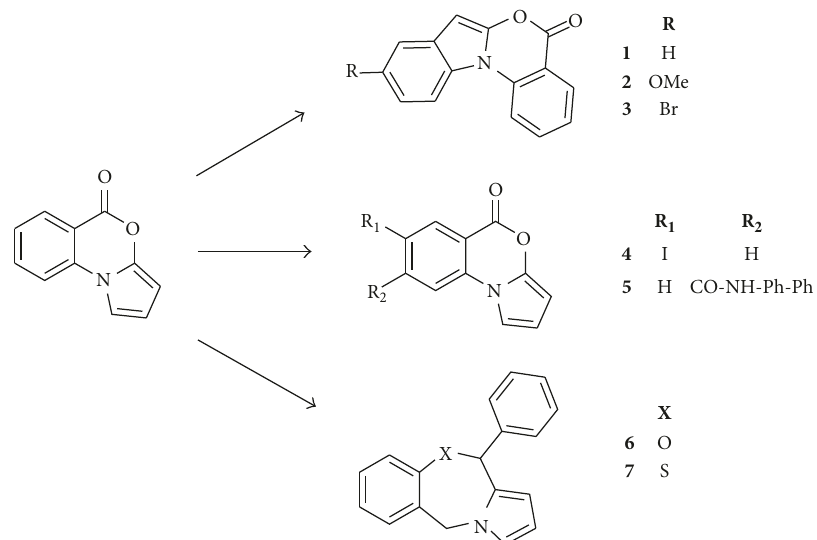
Figure 2: Chemical modifications made to the identified scaffold.